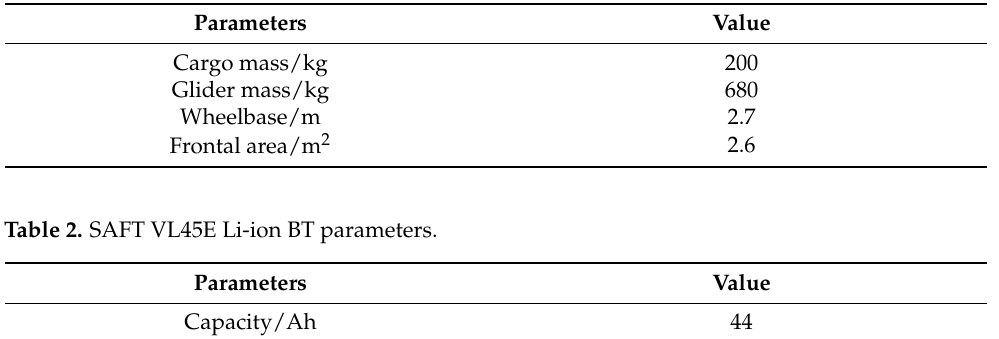
Table 1. EV’s model parameters.